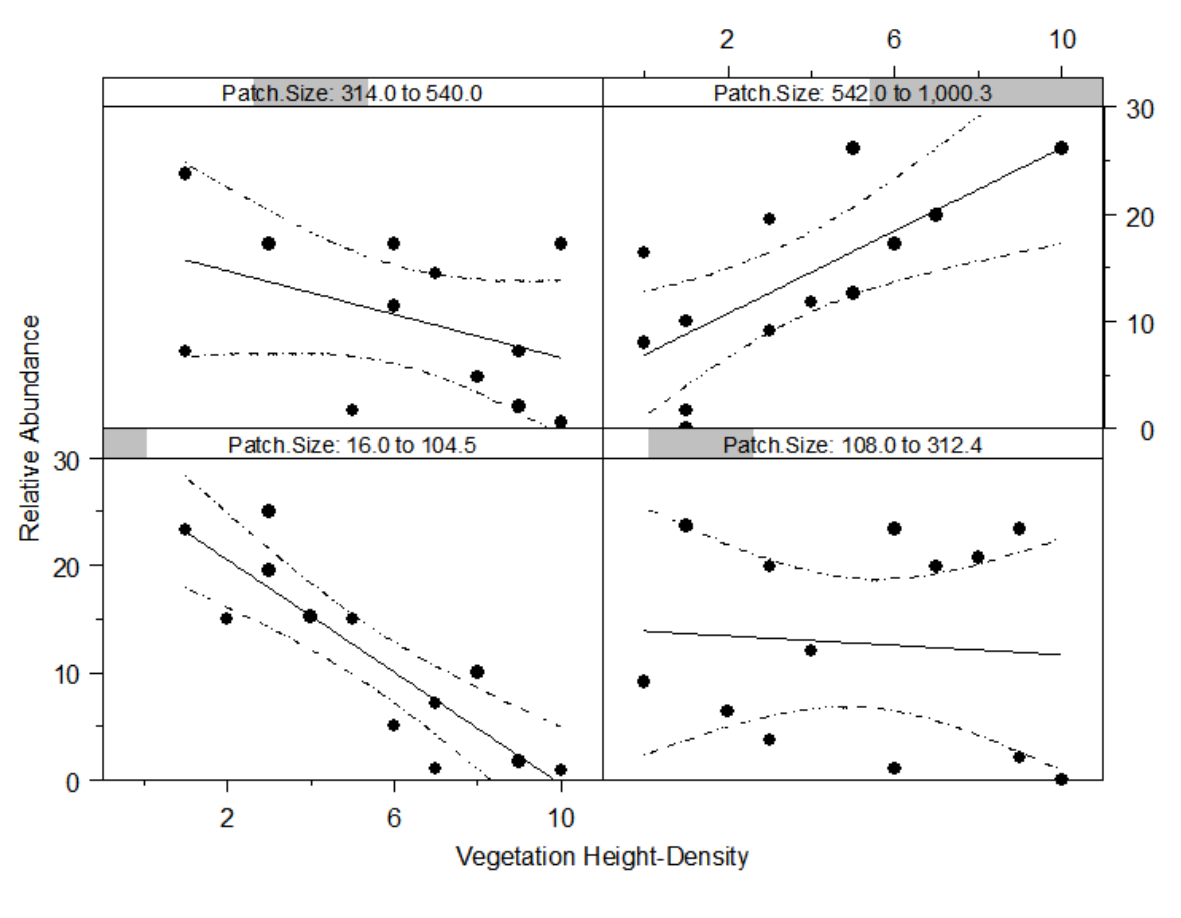
Fig. 1. Patch area sensitivity at the landscape scale may hypothetically influence the relationship between local-scale vegetation height-density and species abundance, explaining the observed habitat relationships of Savannah Sparrow in the study by Nocera et al.